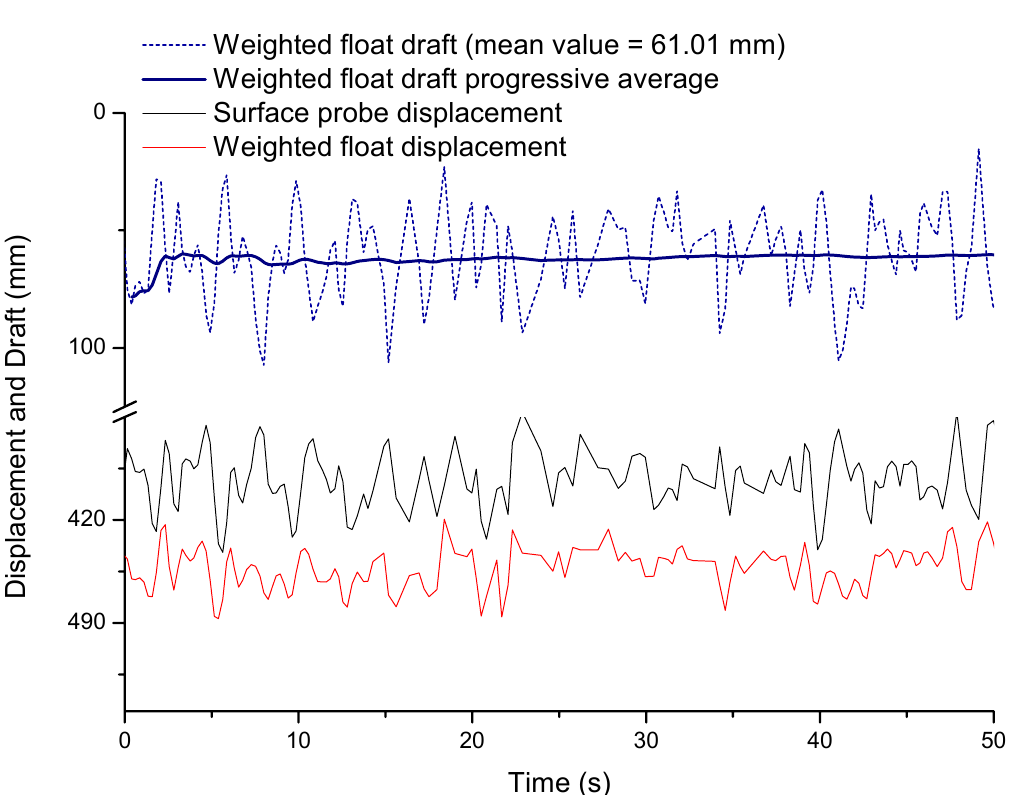
Figure 5. Displacement readings of the two probes in at-sea test experiments. Note the large oscillations due to the waves and the differential reading that gives the weighted float draft. The solid line shows the progressive average of the draft that filters out the effect of the oscillations after just few seconds of